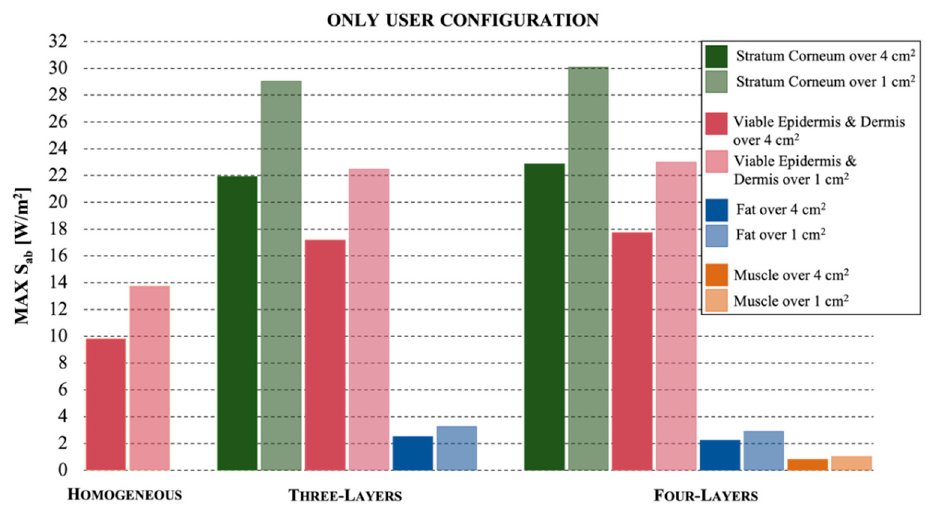
Figure 3. The maximum values of absorbed power density for the configuration where the user is using the mobile phone with a distance of 15 mm, for the three different skin models. using the mobile phone with a distance of 15 mm, for the three different skin